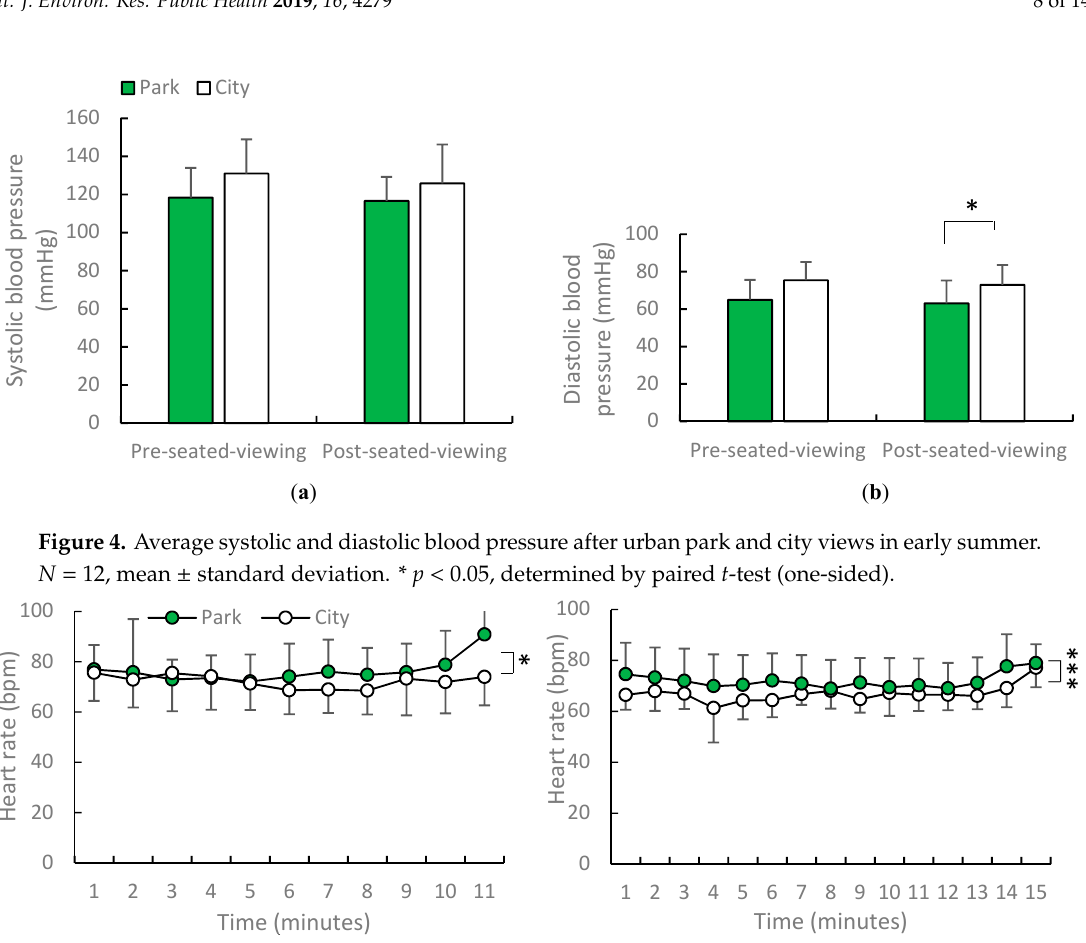
Figure 5. Average one-minute heart rate during urban park viewing in the: ( a ) spring and ( b ) early summer. N = 12, mean ± standard deviation. * p < 0.05, *** p < 0.001, determined by paired t -test (one- sided).